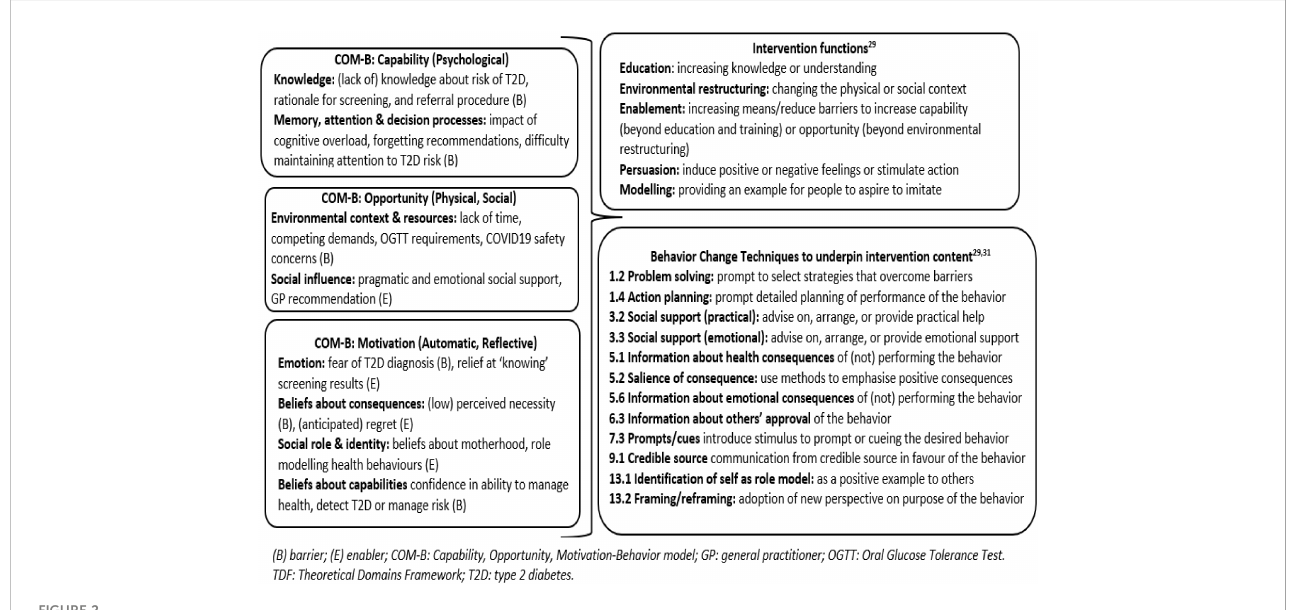
FIGURE 2 TDF domains/COM-B components linked to intervention functions and behavior change